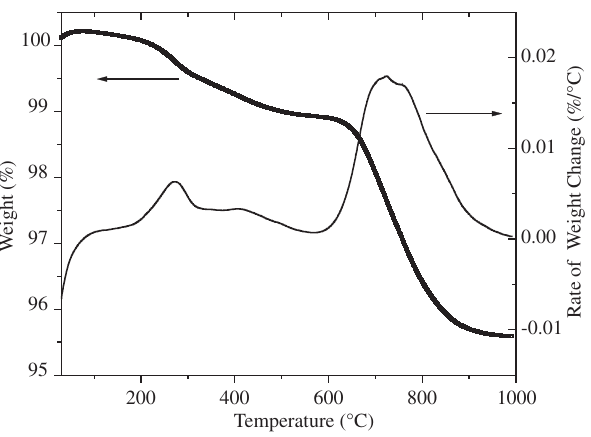
Figure 2. TGA curve and the corresponding rate of weight change curve of the polymer-filler mixture at a constant heating rate of 10 °C min -1 in N